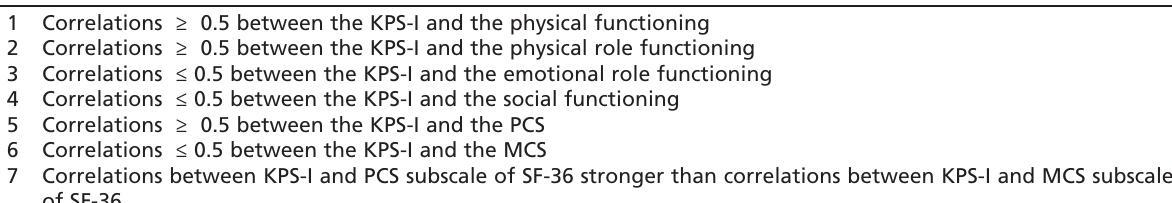
Predefined hypotheses Table I: